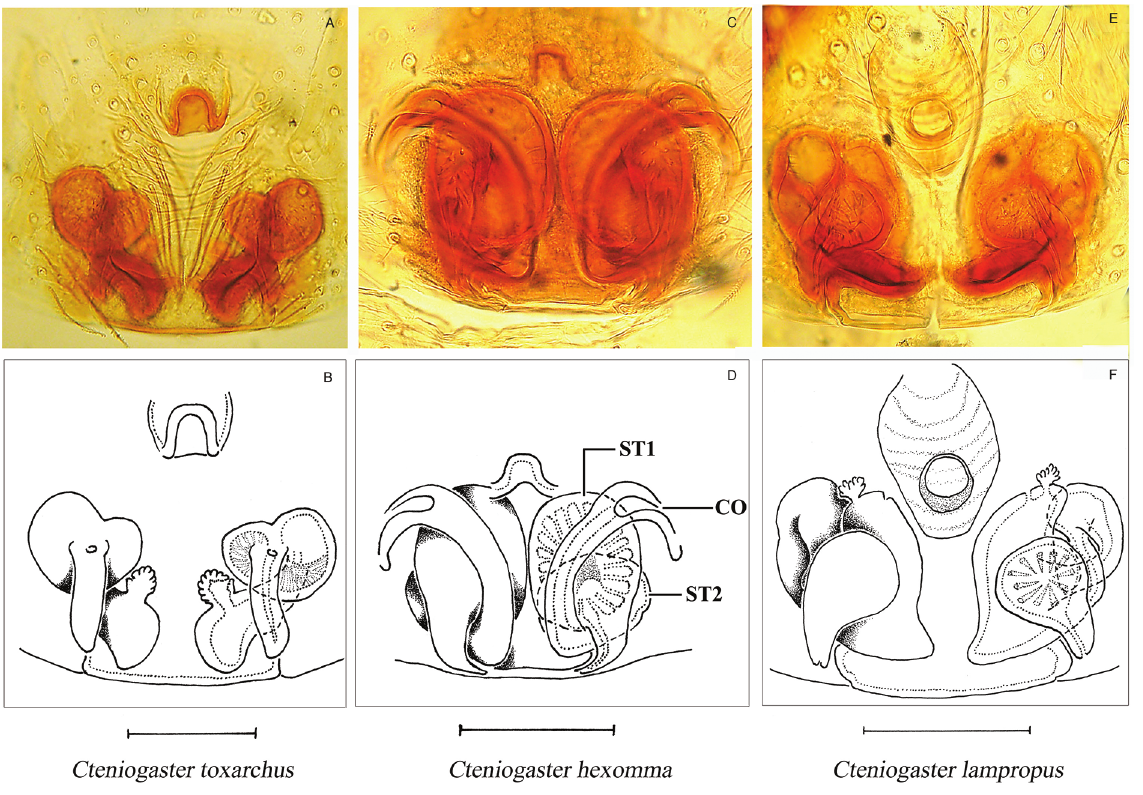
Fig. 4. Female genitalia, ventral view. A, C, E: cleared in methyl salicylate. A-B. Cteniogaster toxarchus gen. et sp. nov. C-D. Cteniogaster hexomma sp. nov. E-F. Cteniogaster lampropus sp. nov. Scale bars = 0.1